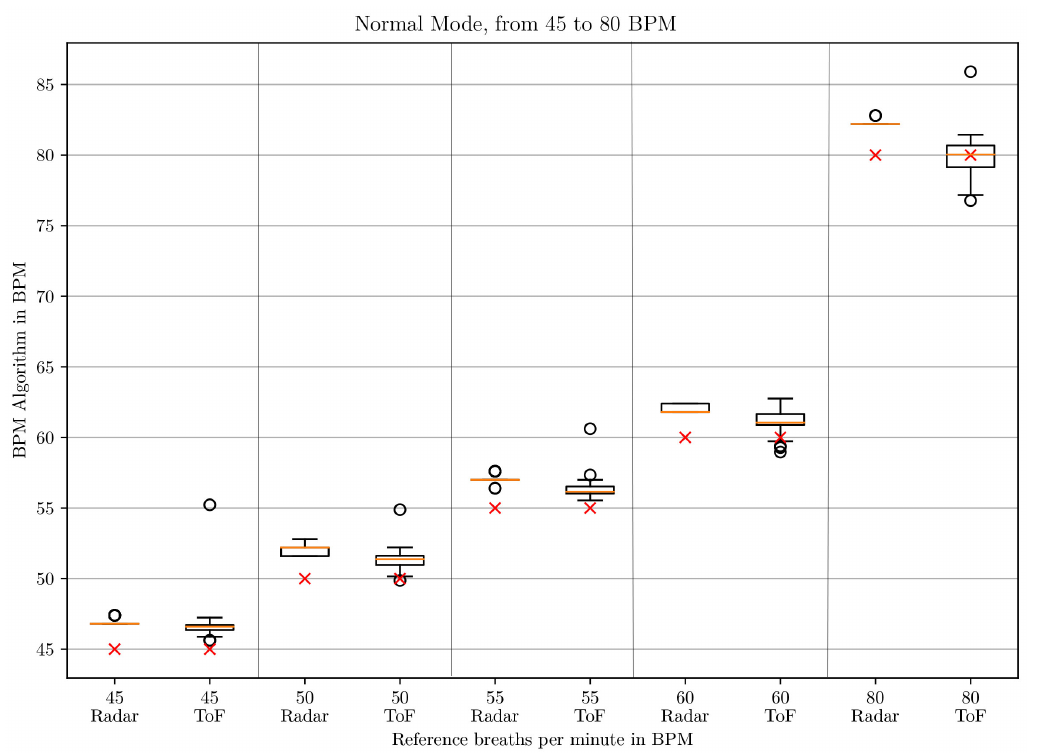
Figure 13. Box plot comparing the BPM values of the ToF and the radar algorithm for respiratory rates between 45 and 80BPM in normal